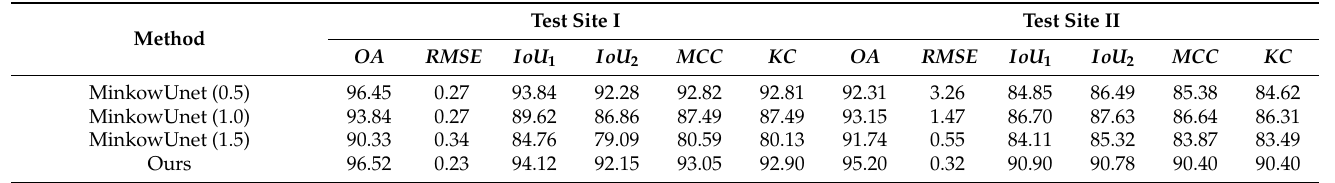
Table 2. Comparison with MinkowUnet-based segmentation methods under different settings.